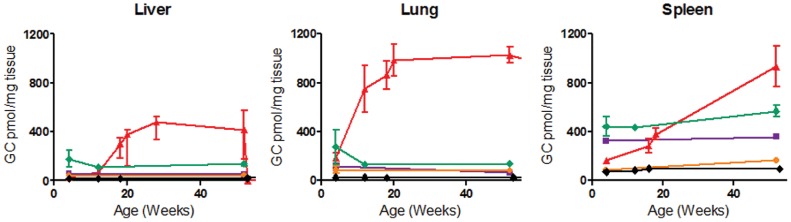
Glucosylceramide (GC) in Gba1 mouse tissues.Total GC levels in liver, lung, and spleen from 9V/null (red), 9H/9H (violet), 9V/9V (green), and 4L/4L (orange) mice. In 9V/null the GC levels progressively accumulated from 4 to 52 wks and at greater rates in the lung than in liver and spleen. 9H/9H, 9V/9V, and 4L/4L mice had GC increases slightly above WT (black) levels. Data are mean±S.E. (n = 3–4 mice).